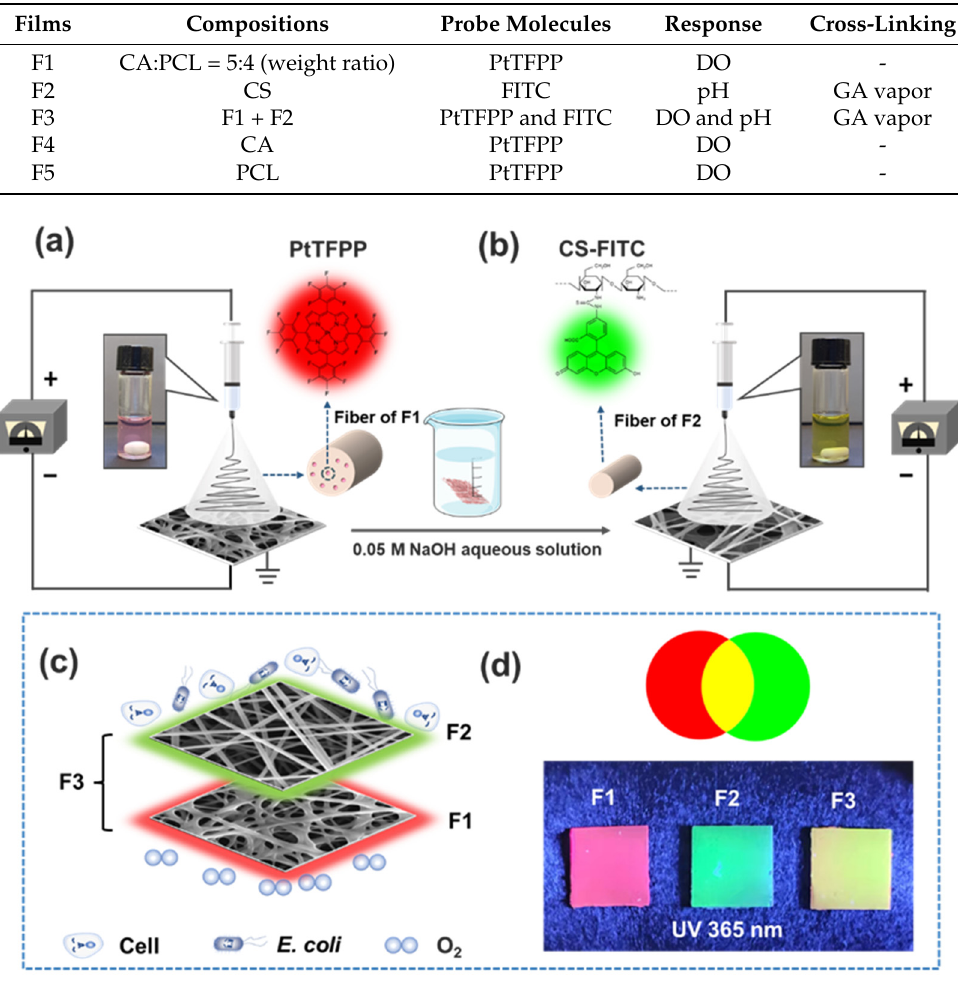
Table 1. Compositions of electrospun sensing films of